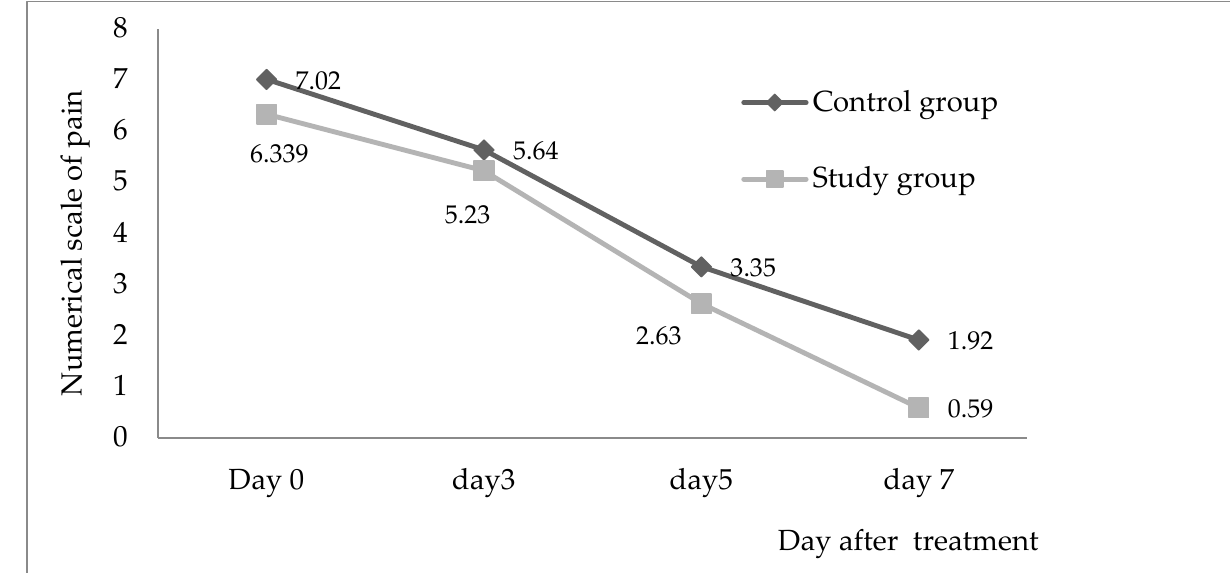
Figure 3. Estimated average score per day after treatment—local pain.